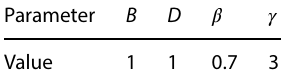
Table 1 Values of model